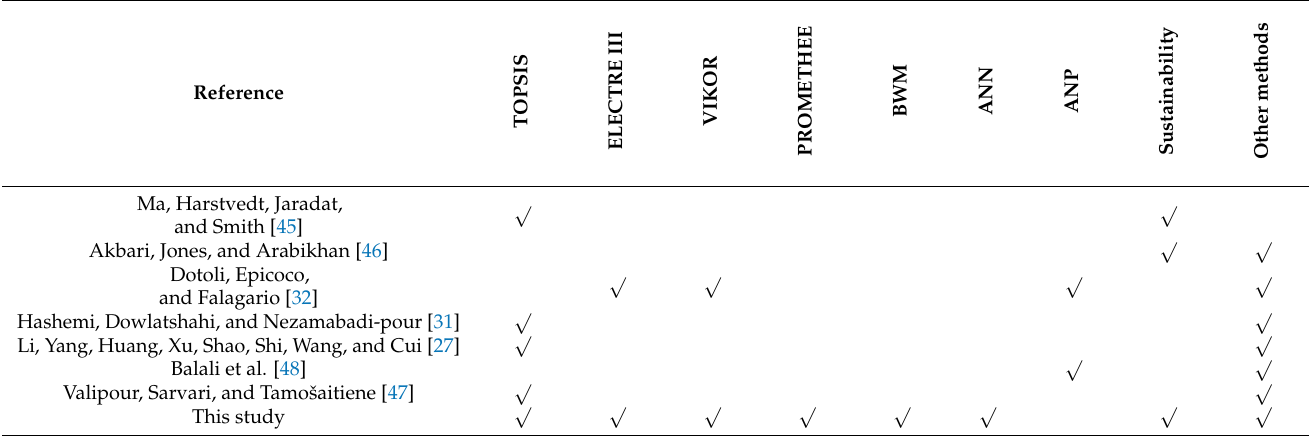
Table 2. A comparison between previous studies and the current